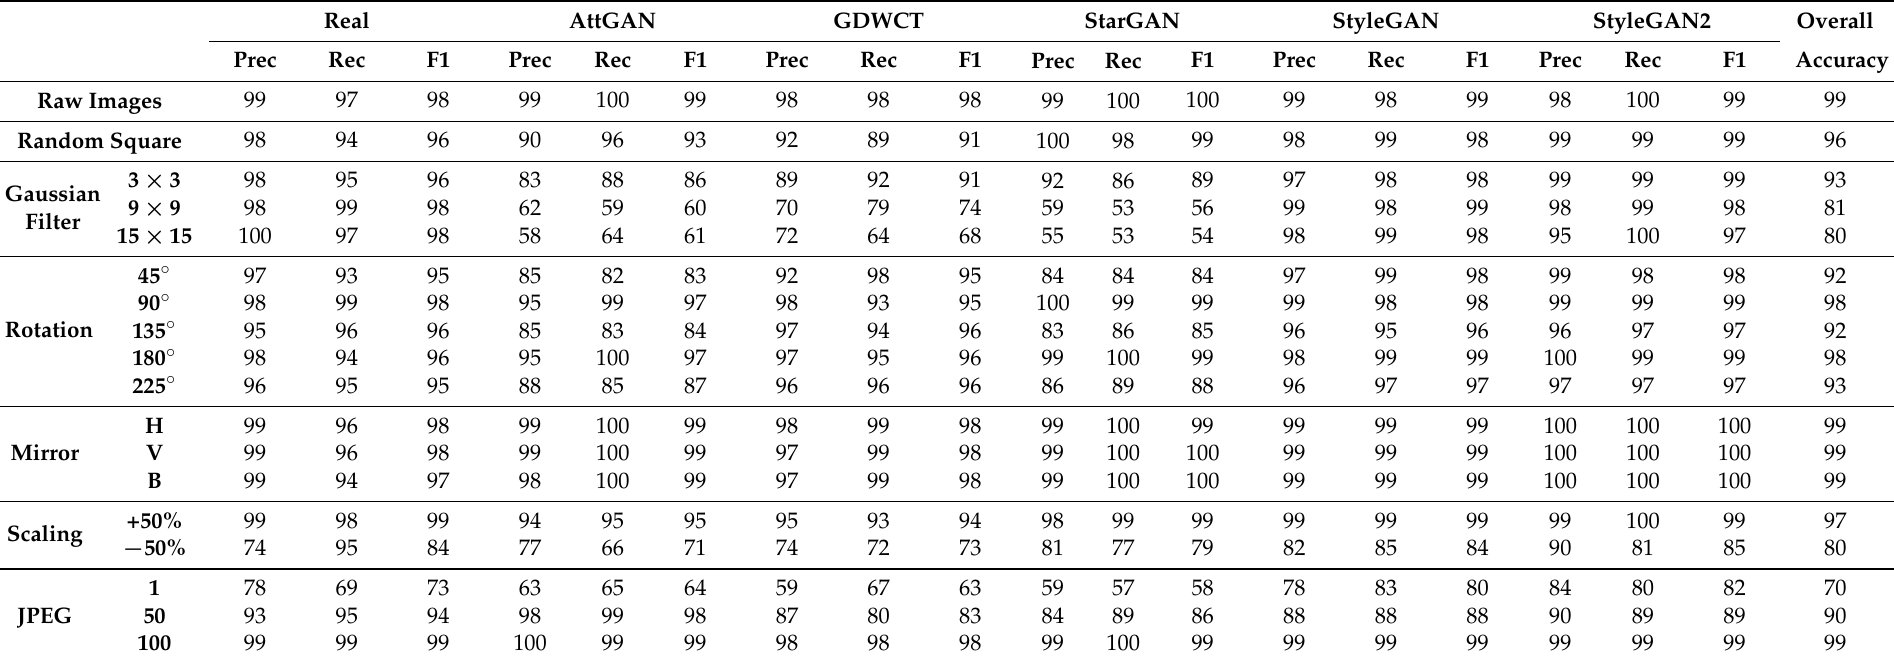
Table 1. Percentage of Precision, Recall, F1-score and accuracy obtained in the robustness test. “Raw Images” shows the results without the attack process. For the “Real” column the CelebA and FFHQ datasets were considered. Different attacks were carried out in the datasets: Random square; Gaussian filter with different kernel size (3 × 3,9 × 9,15 × 15); Rotations with degree = { 45,90,135,180,225 } ; Mirror with Horizontal (H), Vertical (V) and Both (B) ways; Scaling ( + 50%, − 50%); JPEG Compression with different Quality Factor ( QF = { 1,50,100 }